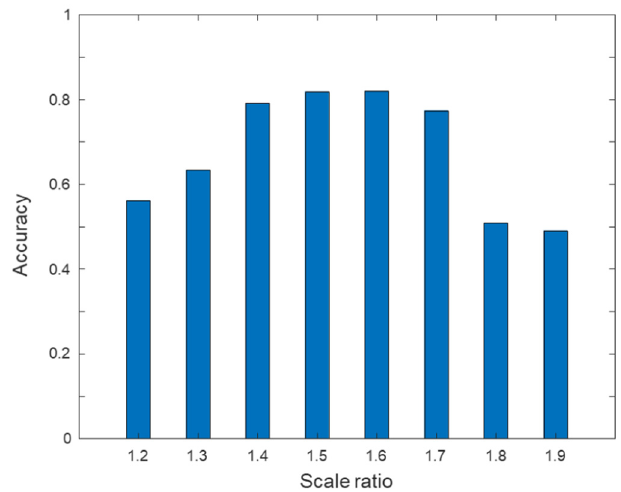
Figure 7. Effects of scale ratio on accuracy.